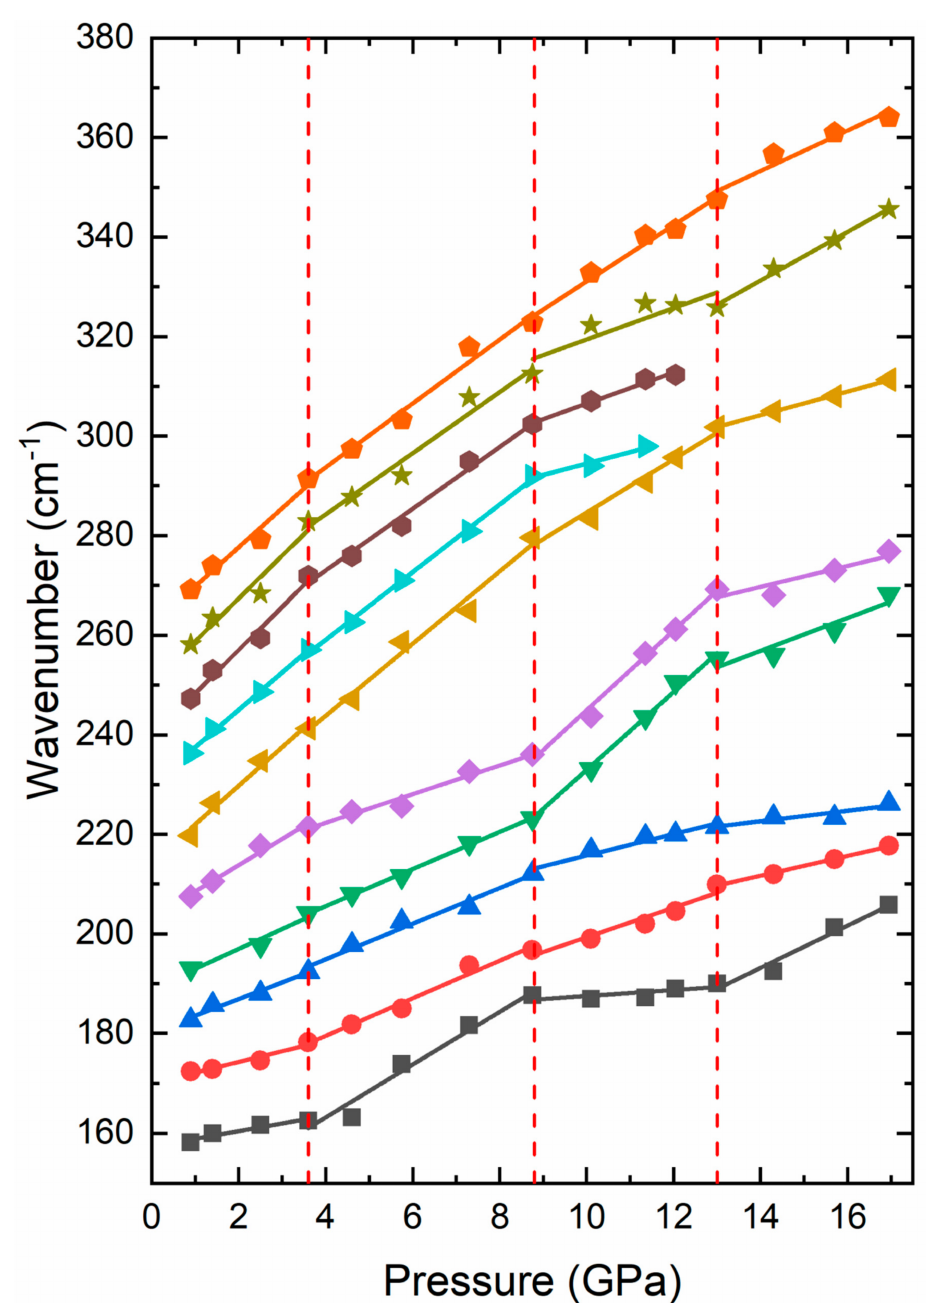
Figure 5. Pressure dependence of IR modes obtained from experiments. Only lattice modes are shown. Vertical lines indicate suggested transition